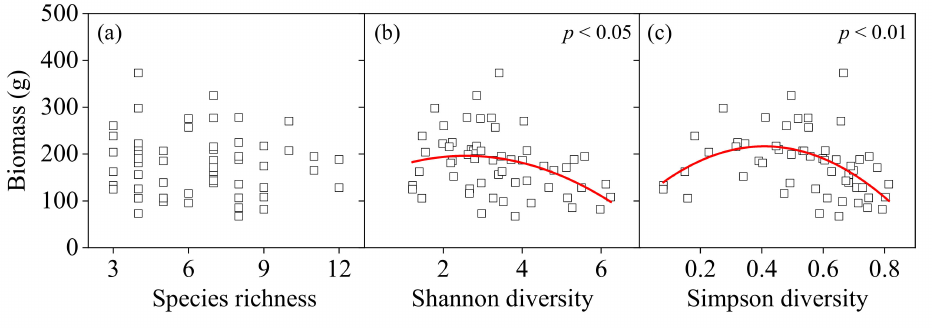
Figure 4. Relationships between aboveground biomass (AGB) and taxonomic diversity metrics ( a – c ).